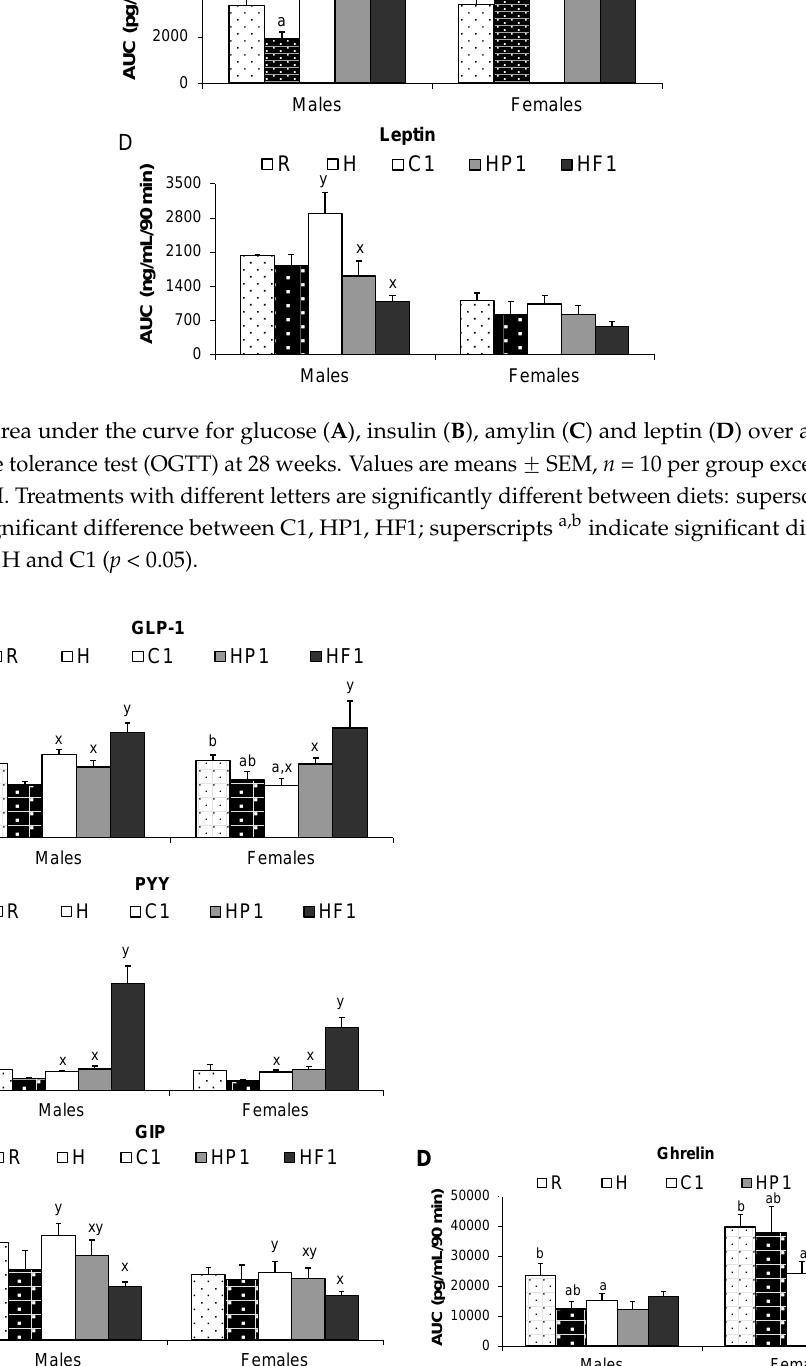
Figure 6. Blood glucose concentrations during an oral glucose tolerance test in male ( A ) and female ( B ) offspring. Values are means ± SEM, n = 10 per group except n = 4 for group H. There was a significant effect of time ( p < 0.05) for males and females. 3.1.4. Liver Triglyceride Diet and sex independently affected liver triglyceride concentrations ( p = 0.001). Liver triglycerides were higher in males than females, and lower in HF1 than C1 and HP1 rats at 28 weeks of age (Table 3). 3.1.5. Hepatic Gene Expression Diet had a significant effect on expression of hepatic SREBP- 1c, ACC, FAS, and AMPKα1 ( p < 0.03) with HP1 rats having higher SREBP1c mRNA levels than HF1 and C1; increased ACC and AMPKα1 mRNA levels than HF1; and increased FAS compared to C1. Sex had a significant effect on SREBP1c and FAS mRNA levels with males having higher expression than females ( p < 0.03). The